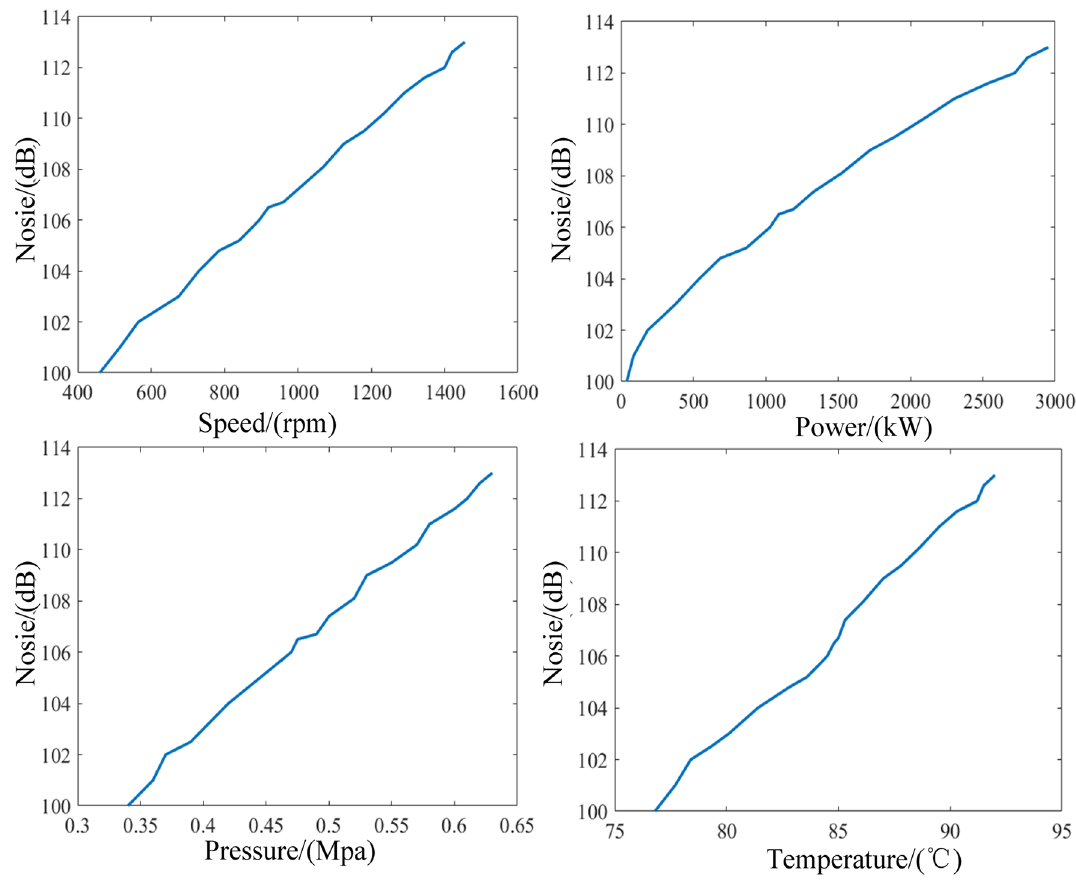
Figure 15. Influence of input parameters on noise.